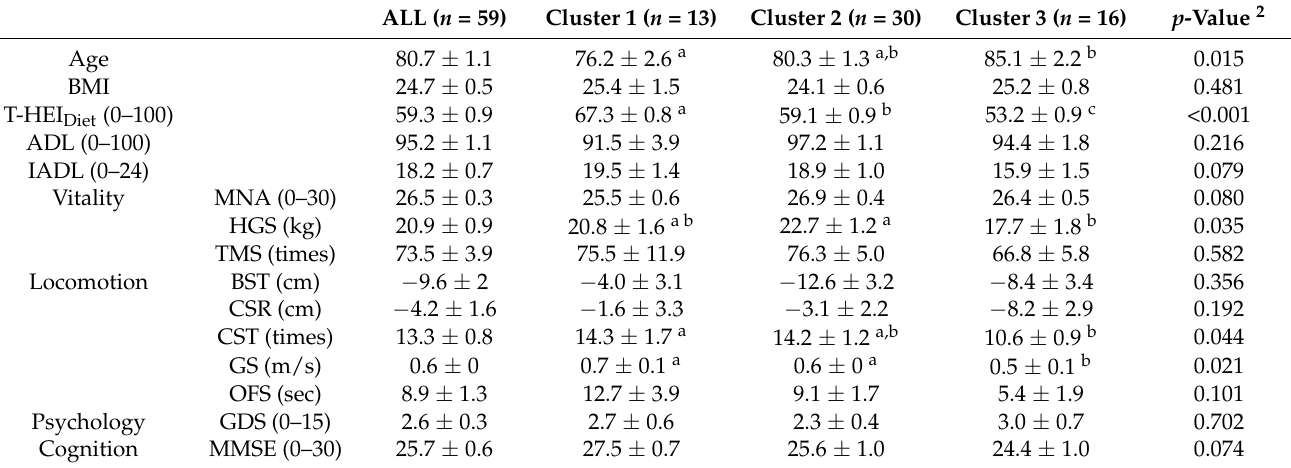
Table 2. Baseline characteristics of all participants and across baseline dietary adherence clusters 1